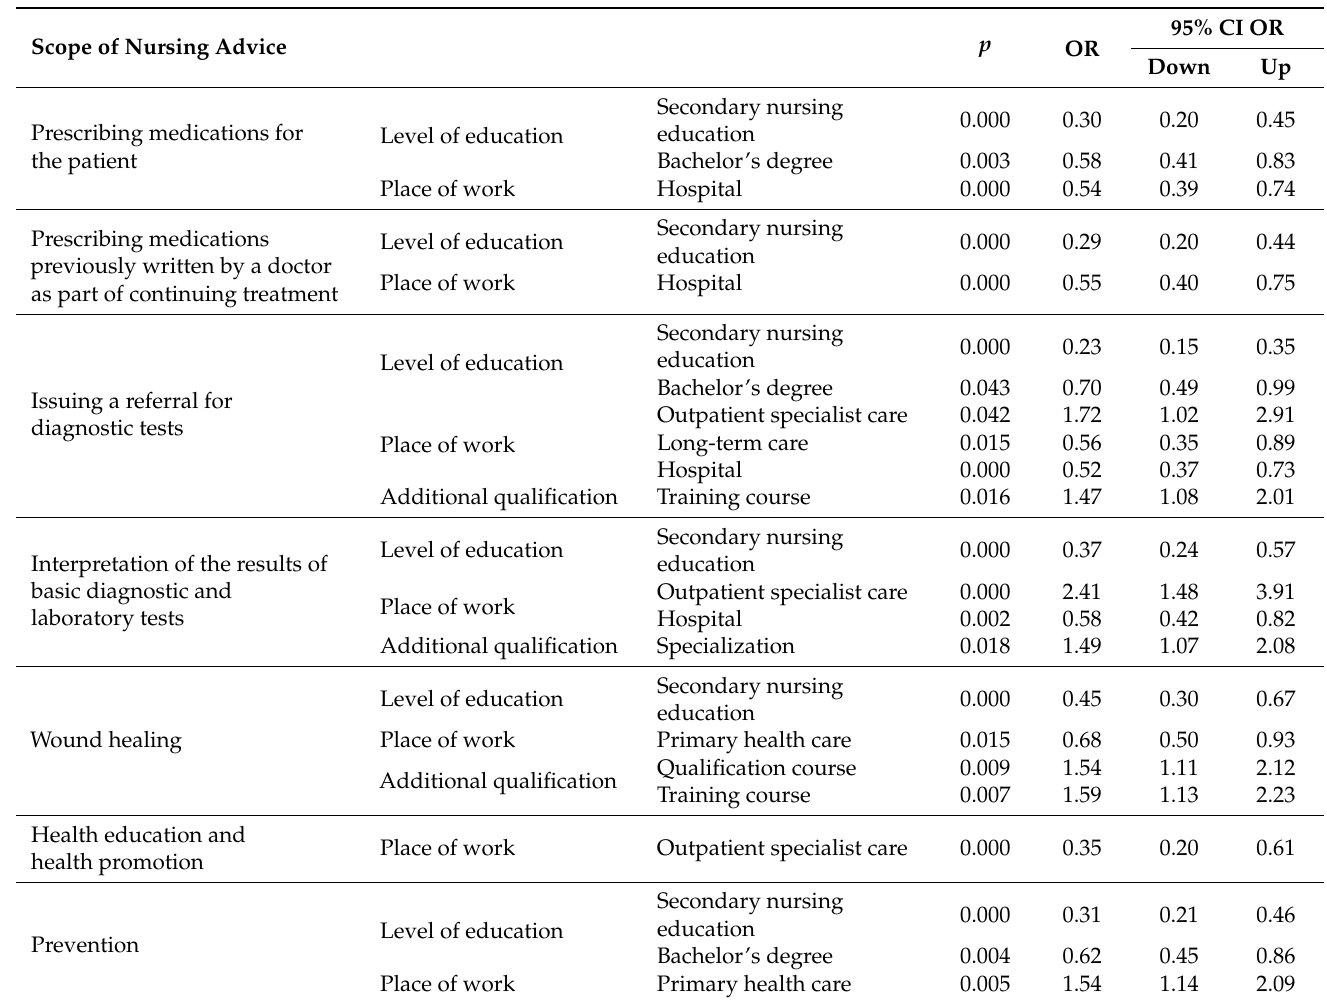
Table 4. Factors influencing nurses’ opinion regarding the scope of nursing advice. Logistic regression—stepwise,